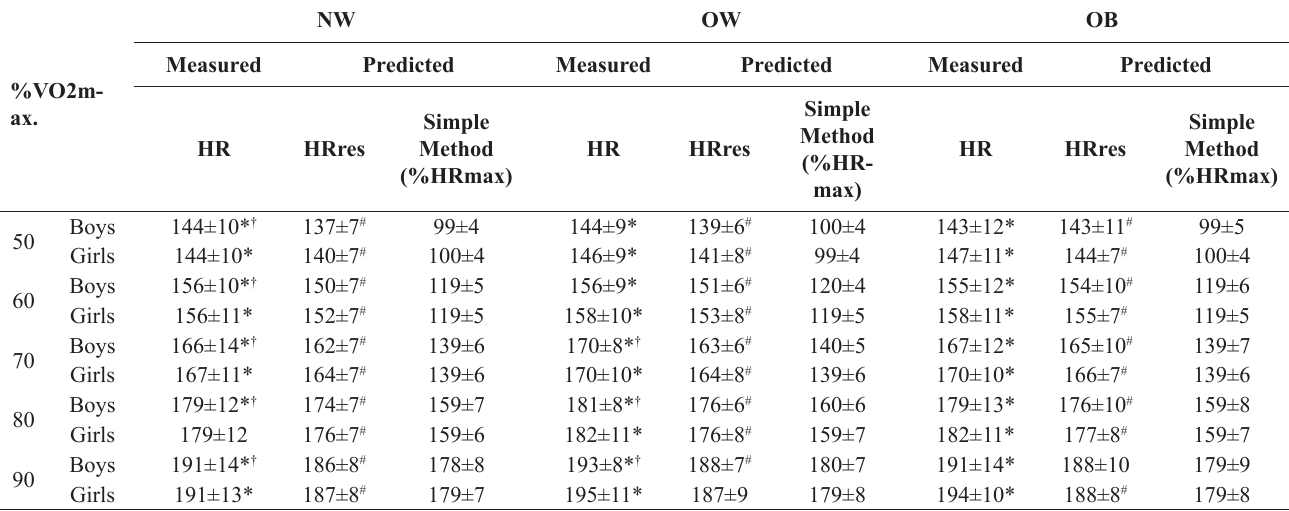
max in normal weight, overweight, and obese adolescents 2